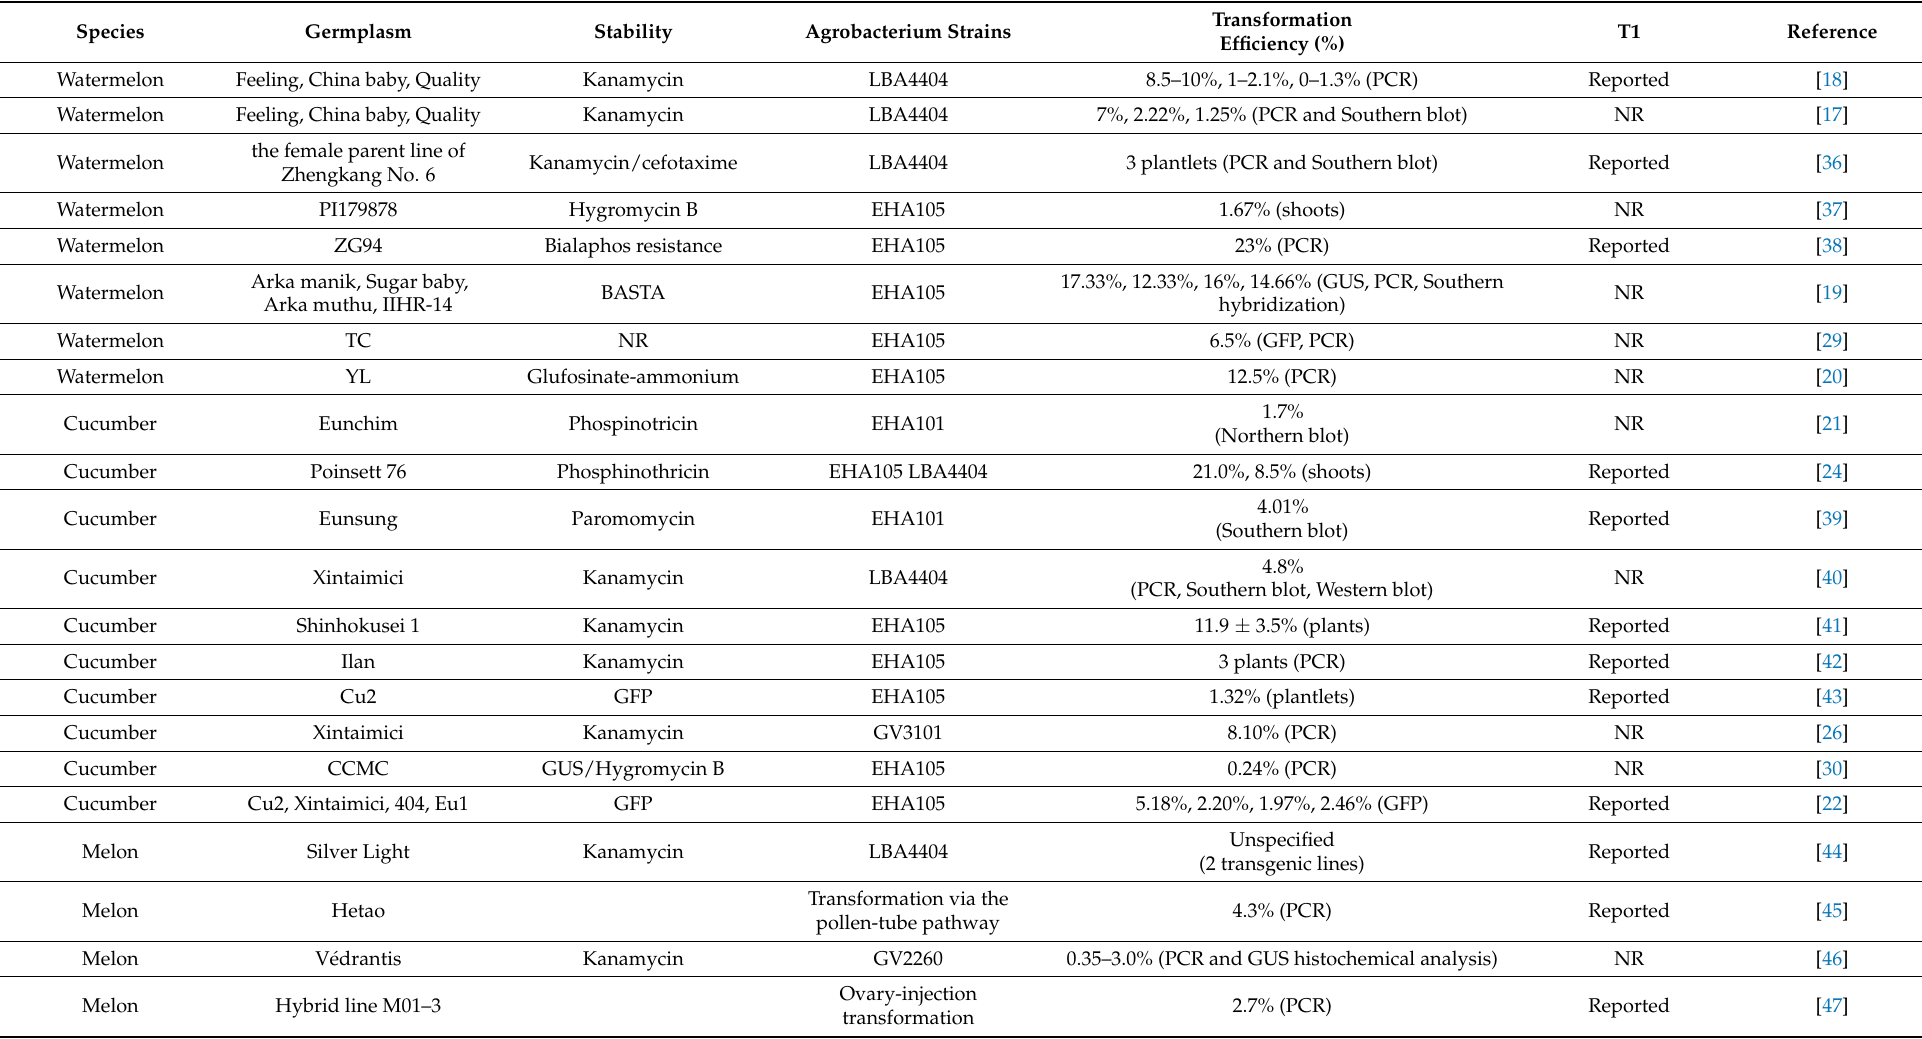
Table 1. Details of some successful reports on Agrobacterium-mediated transformation of cucurbit